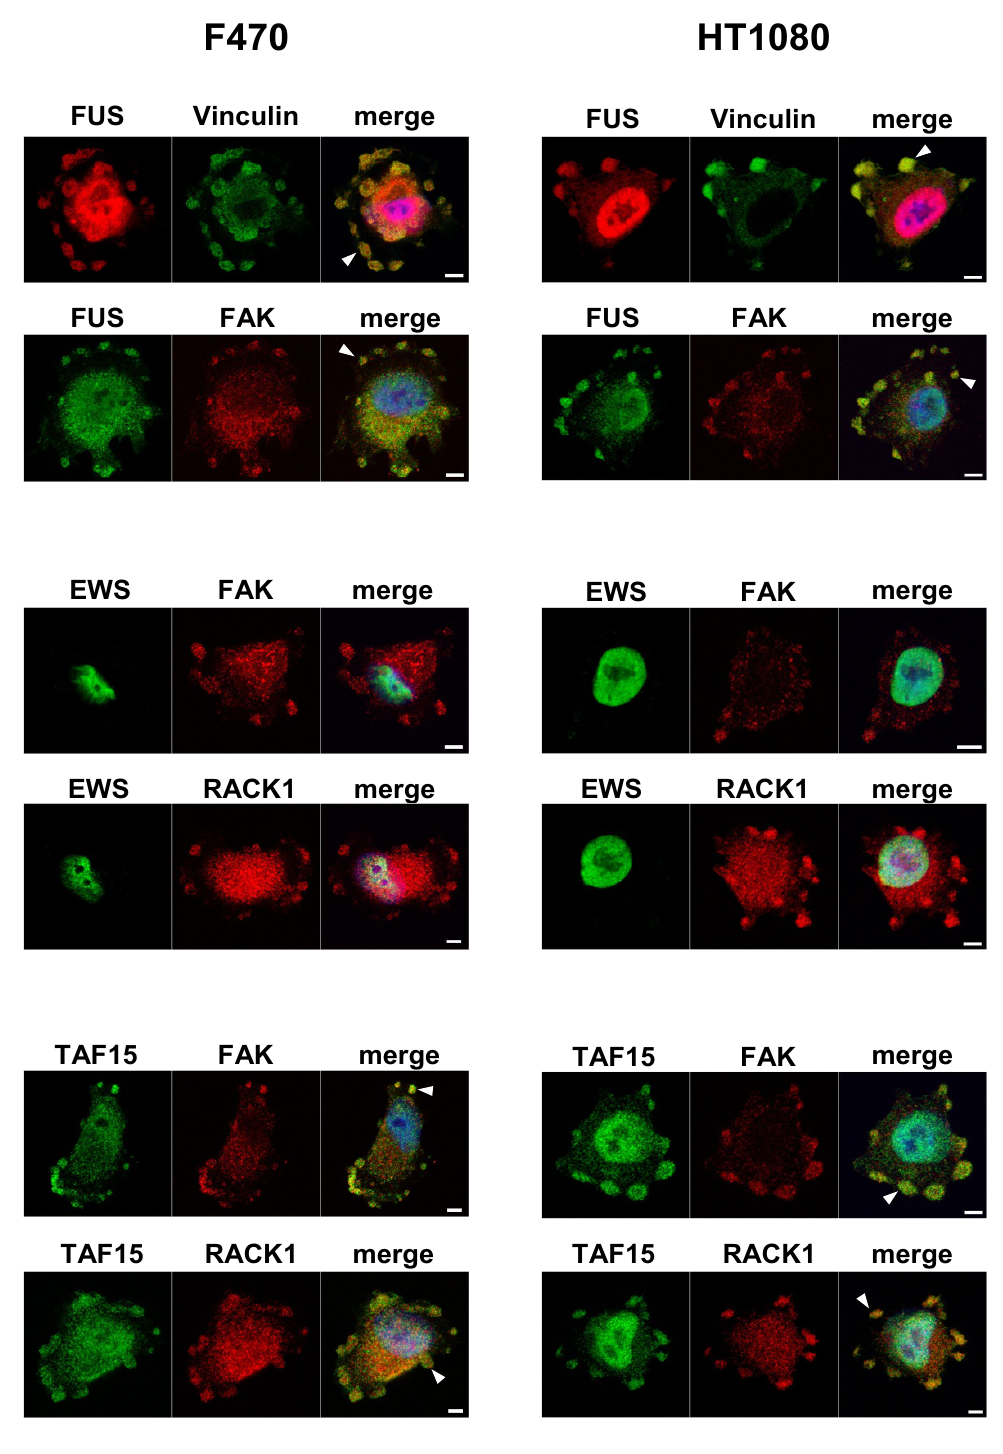
Figure 4 FUS and TAF15 localize to spreading initiation centers . F470 and HT-1080 cells co-stained with FET antibodies and focal adhesion/SIC markers Vinculin, FAK and RACK1. Arrowheads indicate areas of cytoplasmic overlap and nuclei are shown in blue by DAPI staining in the merge images. Bars indicate 5 μ